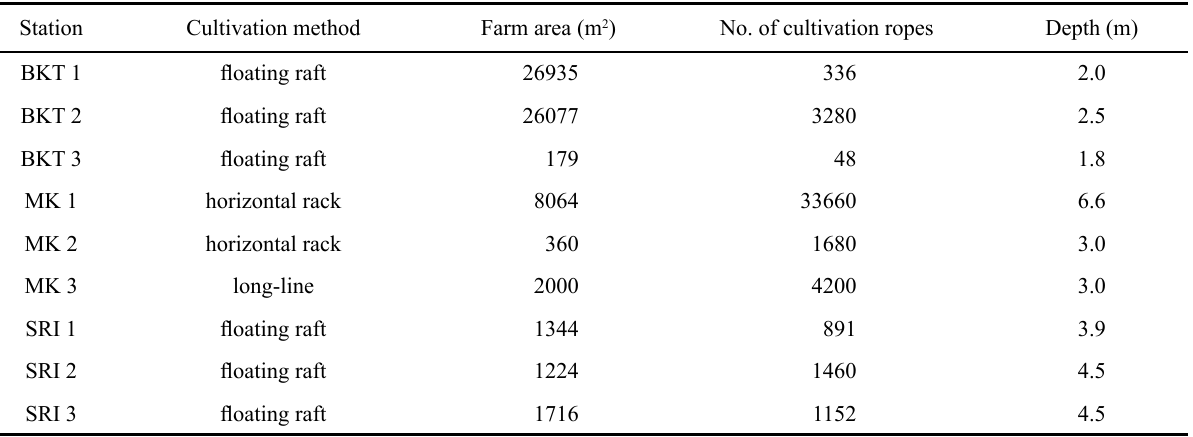
Table 1. – Characteristics of green mussel